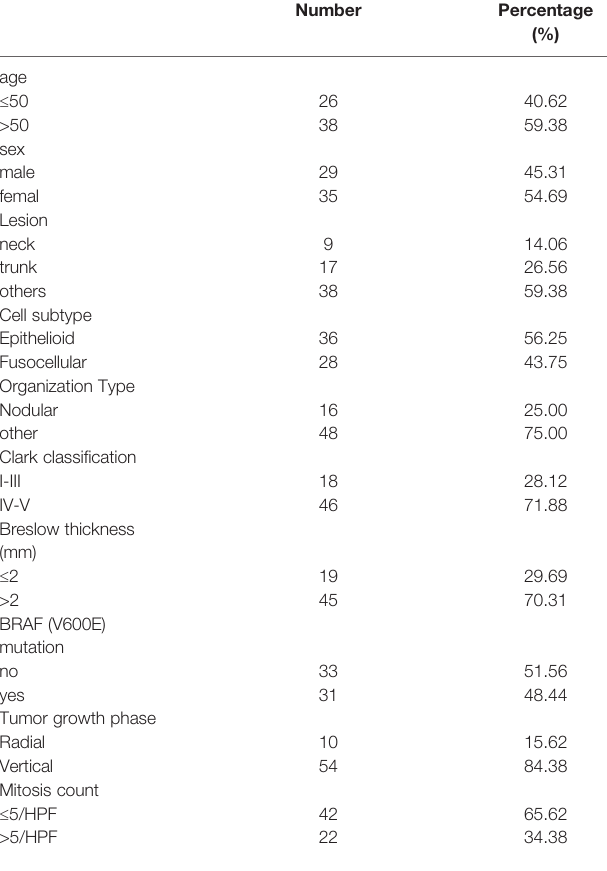
TABLE 1 | Clinicopathological characteristics of